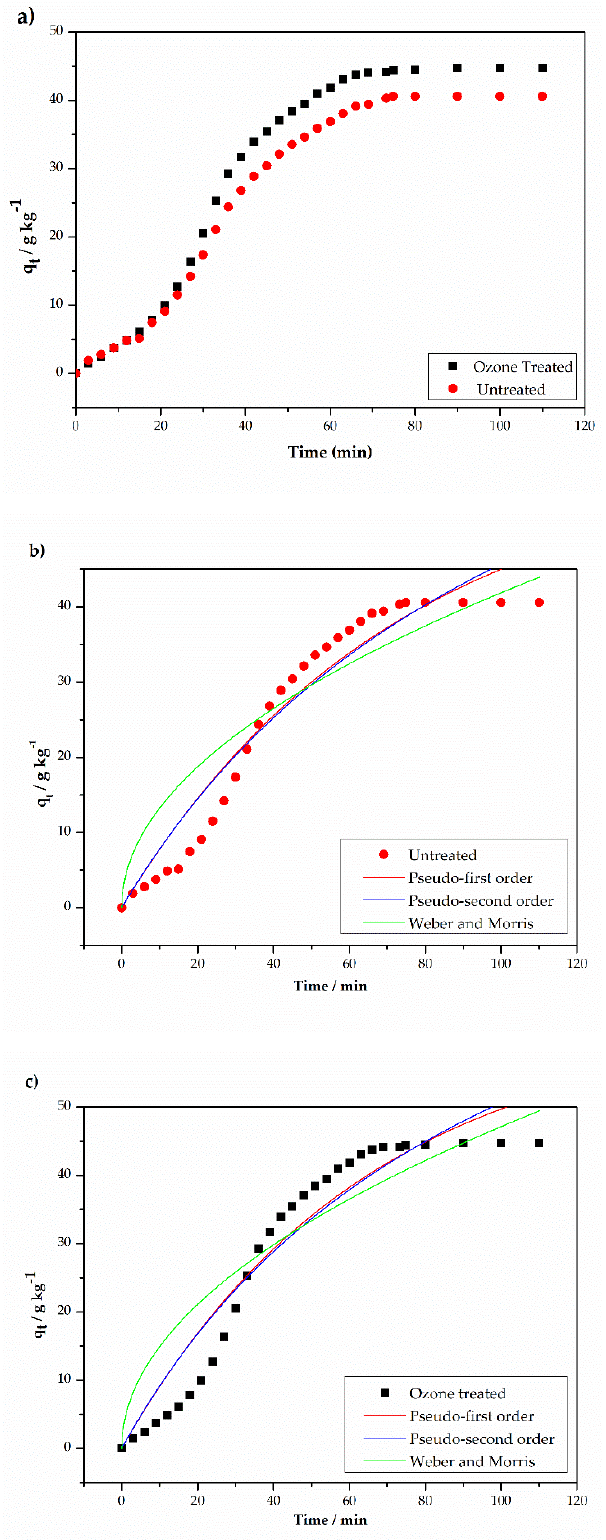
Figure 4. ( a ) Adsorption shape of DY211 dye in treated and untreated polyester fabric over time; ( b ) kinetic models adjustment for sample without treatment; ( c ) kinetic models adjustment for treated